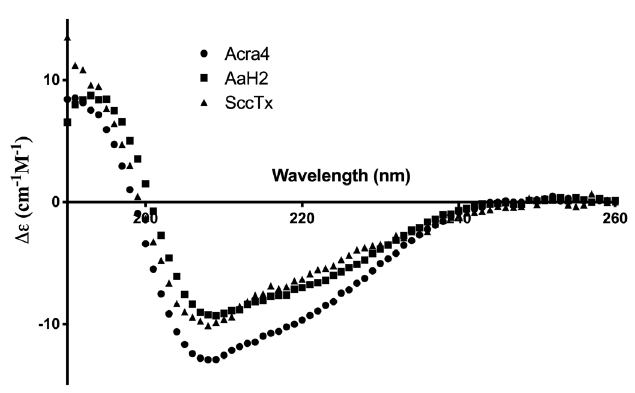
Figure 3. Circular dichroism of recombinant proteins HisrAcra4, HisrSccTx and native AaH2. The secondary structure fractions of the CD spectra according to Micsonai et al. [32] were: α-helix 0.36, 0.42, 0.34; β-sheet 0.21, 0.12, 0.10; and random coil 0.35, 0.25, 0.35 for HisrAcra4, HisrSccTx and native AaH2,